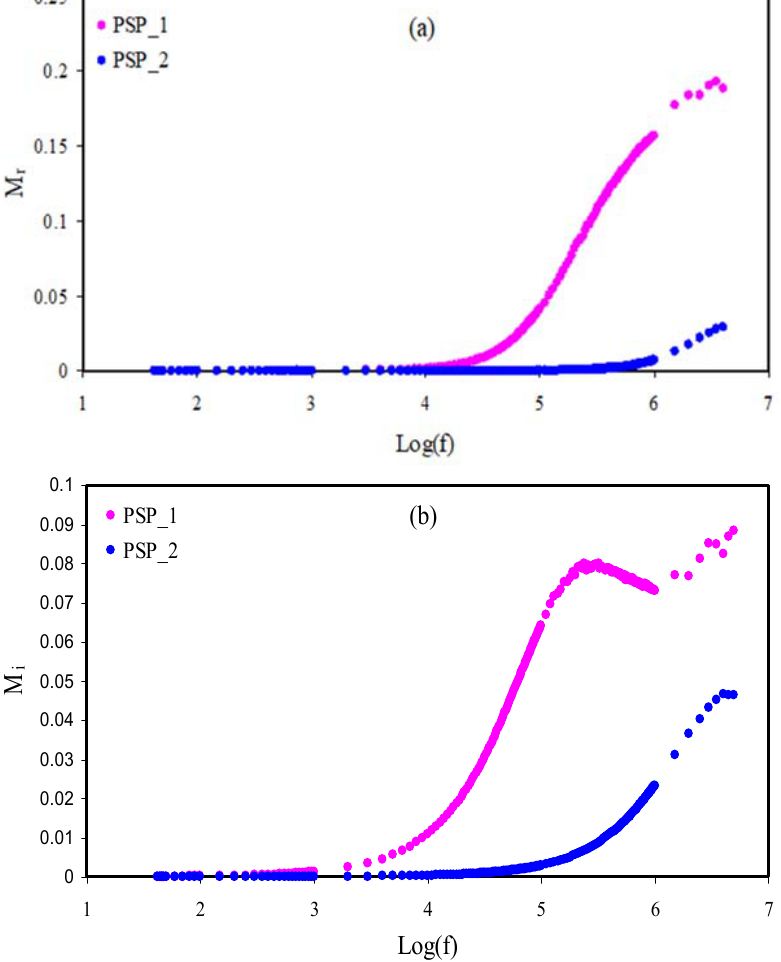
Figure 7. Electric modulus of ( a ) M r v log(f) and ( b ) M i v log(f) for PSP_1 and PSP_2 electrolyte samples at RT.